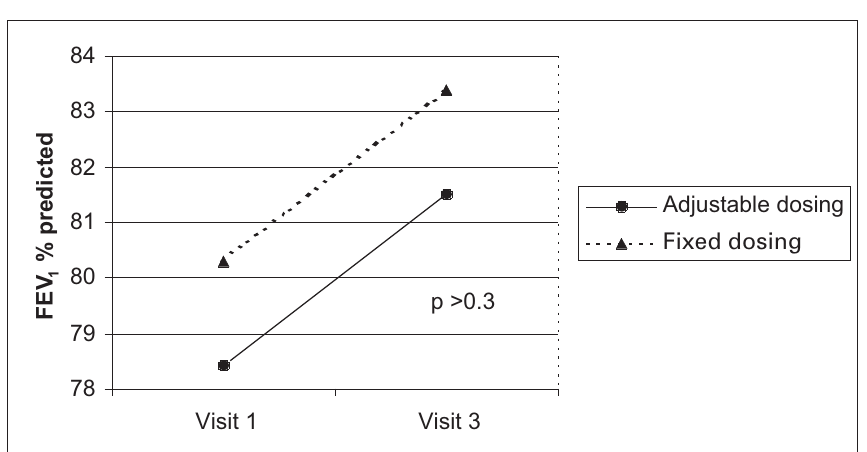
No. of treatment